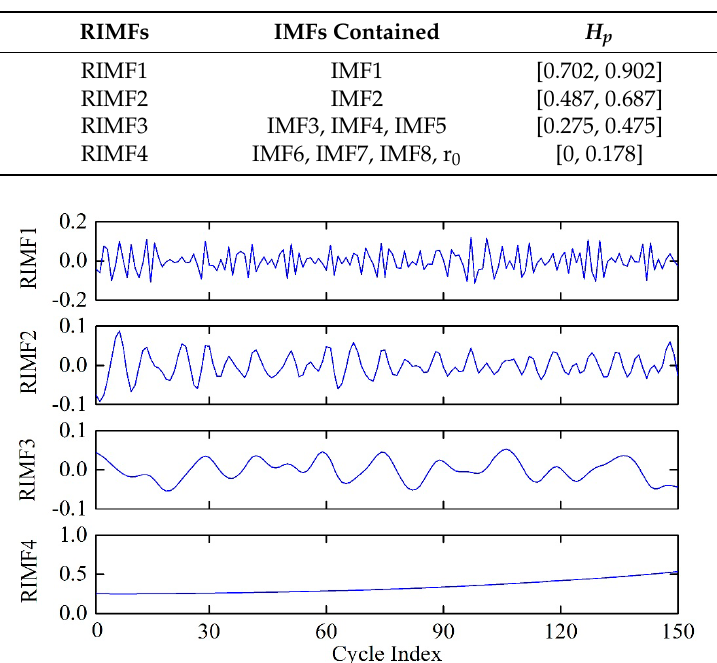
Table 4. Analysis of IMF reconstruction results after FEEMD. RIMF—refactored IMF.